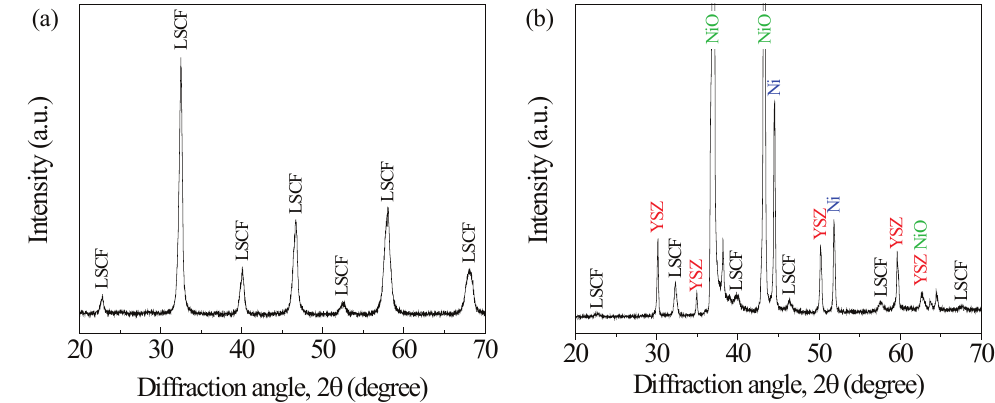
Figure 9. X-ray diffractometer (XRD) patterns of the ( a ) synthesized LSCF powder after calcination; and ( b ) LSCF-Ni/YSZ anode after stability test in CH